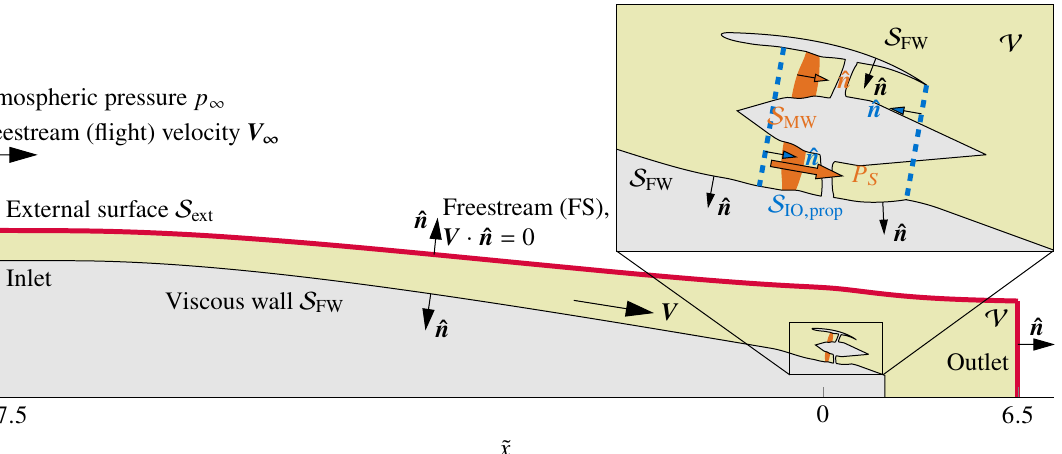
Figure 3. Control volume for mechanical power balance. The external surface V surfaces in orange, stationary viscous walls S MW are in S IO,prop